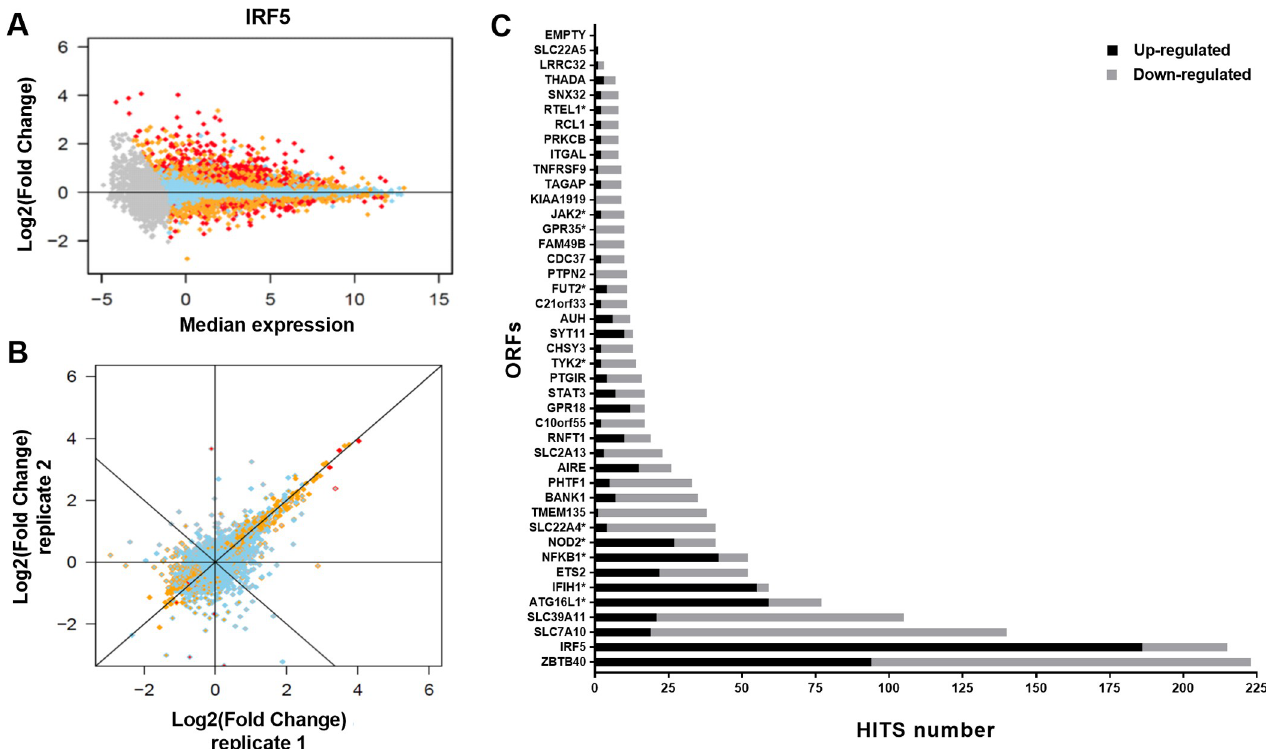
Fig 1. Impact of IBD gene candidate ORFs on the THP-1 transcriptome. (A) Selected example illustrating impact observed on the transcriptome of THP-1 cells following the expression of IRF5. Each dot represents a single detectable gene in the THP-1 transcriptome. The x-axis shows the log 2 -transformed median expression across all conditions tested (baseline). The y-axis represents the effect of transduction and expression of a given ORF, as the log 2 -transformed fold- induction compared to baseline. Skyblue dots represent genes with expression value within expected variation (|Z| � 2), orange dots represent genes suggestively outside the range (|Z| > 2) and red dots represent genes outside expected range of variation (|Z| > 4). Gray dots are genes with expression value below our detection threshold. Additive effect in log2 correspond to multiplicative effect on the original scale. The fold-change equivalent to a given effect log2-effect x is then: FC = 2 x . As an example, an effect of 1 correspond to a FC = 2. (B) Correlation of effect of independent sets of replicated expression of IRF5 on THP-1 transcriptome. The x-axis (inner color of dots) and y-axis (border color of dots) show the effect of two independent set of replicated ORFs on the transcriptome, as the log 2 -transformed fold-induction compared to baseline. Variation between sets of replicates includes effect of independent infection dates, RNA extraction, expression arrays and batches. (C) Impact of the transduction and expression of all 42 IBD gene candidate ORFs on the transcriptome of THP-1 cells. ORFs are ordered by their total number of HITS, with the number of up- and down-regulated HITS illustrated by black and gray, respectively (S2 Table & S1 Appendix ). Starred ORFs are previously reported IBD candidate causal